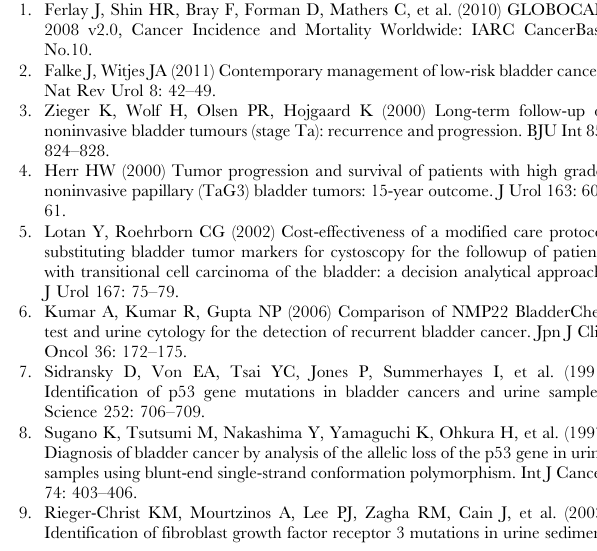
Table S1 Oligonucleotides and amplification conditions. Table S2 Methylation levels of the BCL2 promoter CpG island in urine samples from seven bladder cancer patients. Table S3 Demographic and clinico-pathological characteristics of bladder tumor